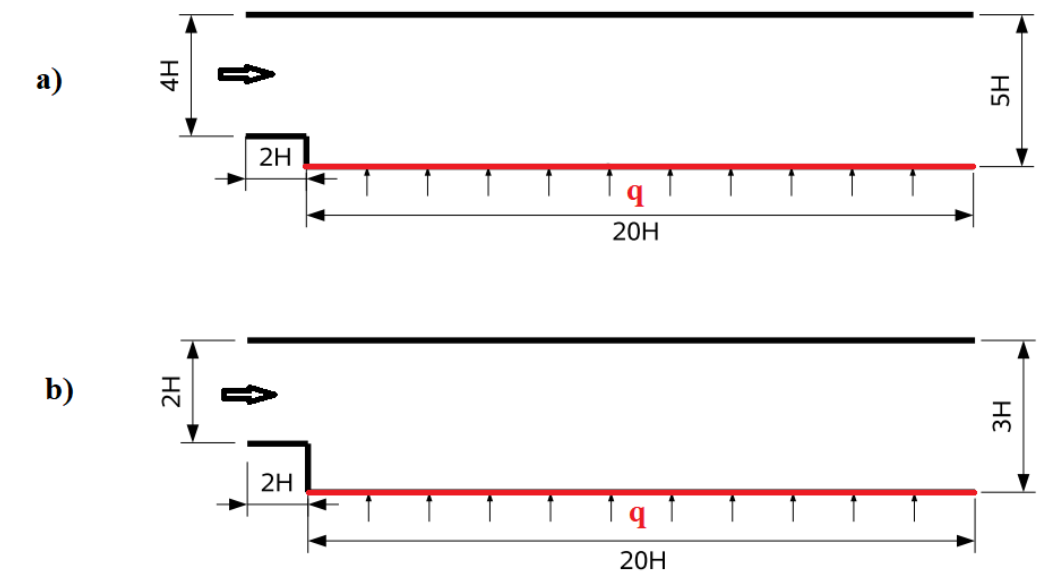
Figure 2. Computational domain for ( a ) first configuration and ( b ) second